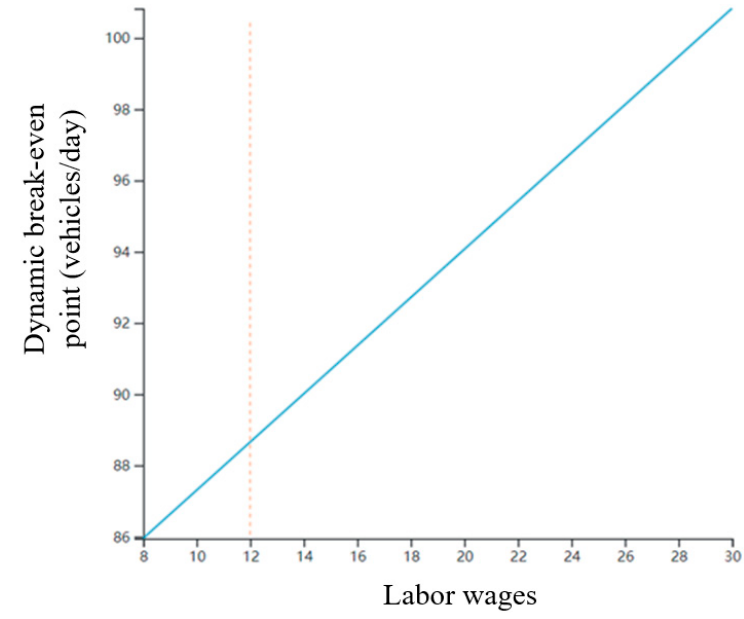
Figure 11. Sensitivity analysis of labor wages.